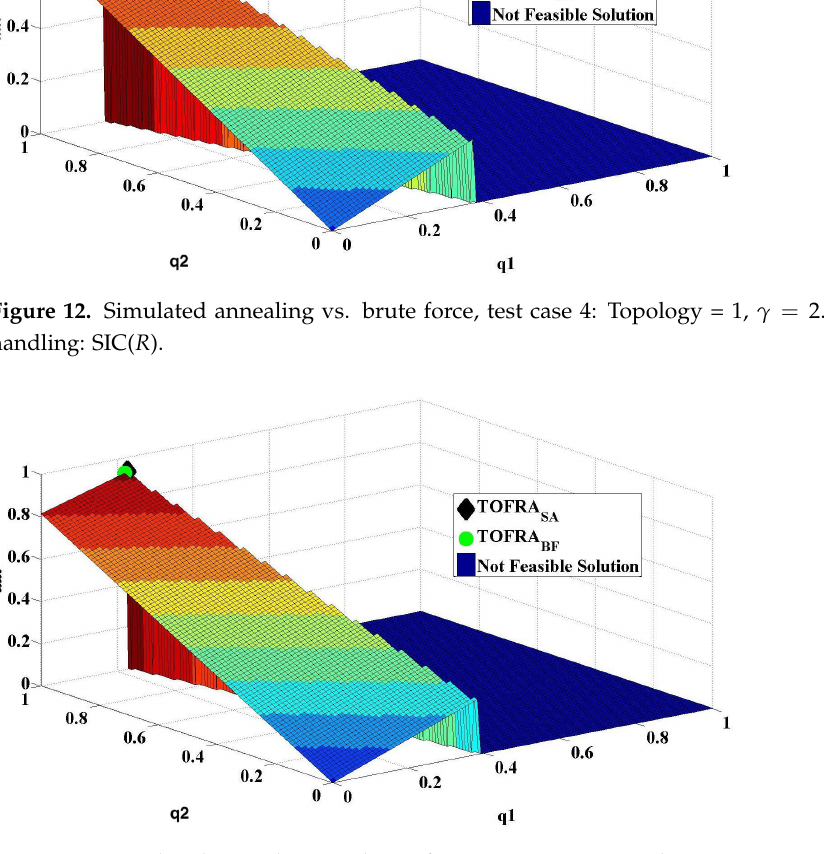
Figure 13. Simulated annealing vs. brute force, test case 5: Topology = 1, γ = 1.0, Interference handling: